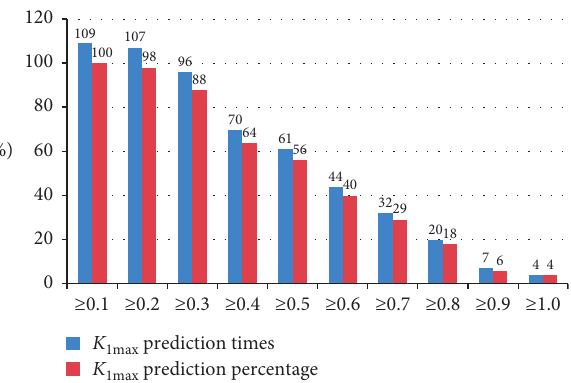
Figure 6: Distribution of K